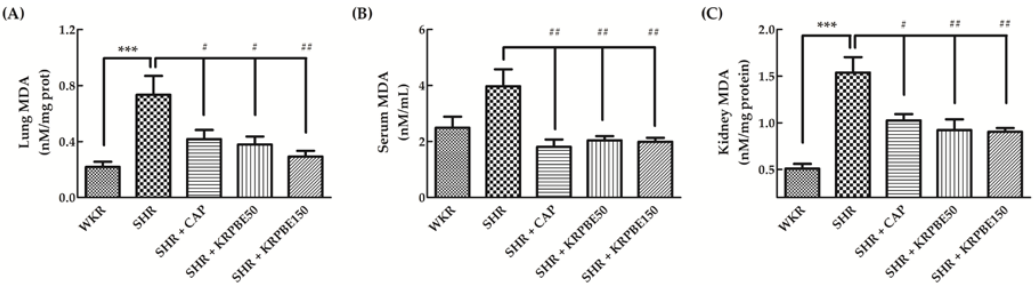
Figure 4. Malondialdehyde (MDA) content in lungs ( A ), serum ( B ), and kidneys ( C ) of WKRs and SHRs after seven weeks of oral administration. WKR group (tap water), SHR group (tap water), SHR + CAP group (15 mg/kg body weight/day of CAP), SHR + KRPBE50 group (50 mg/kg body weight/day of KRPBE), and SHR + KRPBE150 group (150 mg/kg body weight/day of KRPBE) were orally administrated for seven weeks. Each group consists of six rats. Tukey-Kramer honestly significant difference test: *** p < 0.001 vs. WKR and # p < 0.05, ## p < 0.01 vs. SHR.